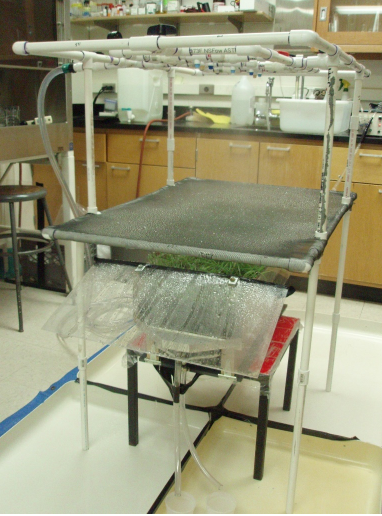
Figure 1. Complete laboratory-scale rainfall simulator and tilting soil bed system.